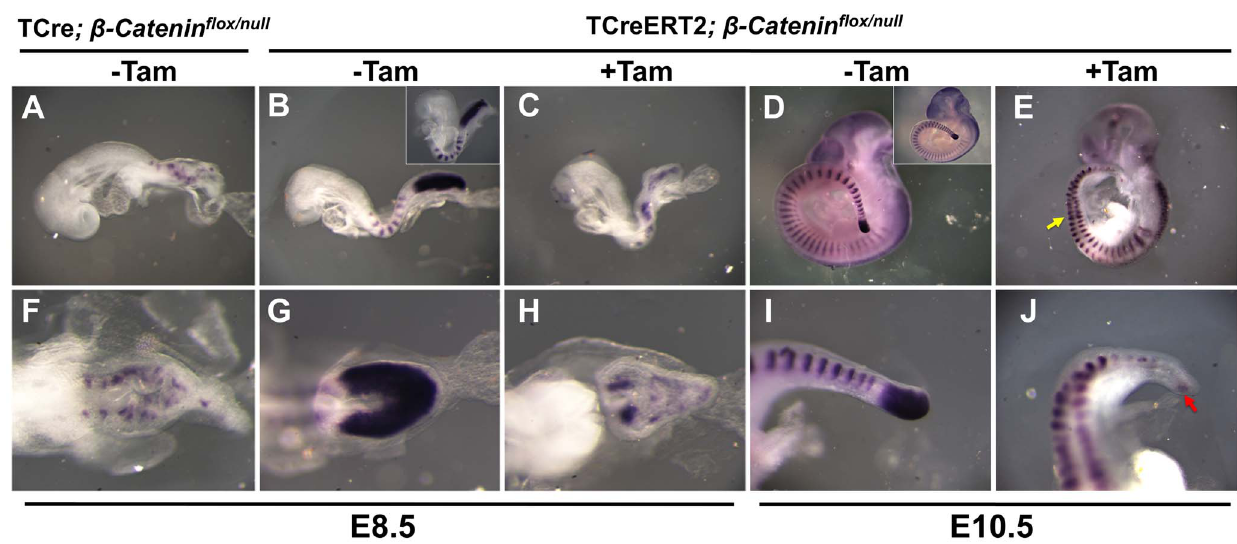
Figure 4. TCreERT2-mediated deletion of ß-catenin at different axial levels. All embryos shown, of the indicated genotype and stage, with or without a 48-hour Tam induction, were stained for expression of the markers Uncx4.1 and Msgn1 . Both markers were developed with the same color reaction, but they mark mutually exclusive domains: Uncx4.1 is expressed only in stripes in the somites and Msgn1 is expressed only in the PSM. A–E are lateral views and F–J are either dorsal views ( F–H ) or magnified views of the caudal end of the embryo immediately above ( I, J ). TCre- mediated deletion of ß-catenin causes caudal truncation and disorganized somites at E8.5 ( A, F ). These E8.5 defects are phenocopied in the Tam- induced TCreERT2; ß-catenin flox/null embryos ( C,H ) but not in the uninduced control ( B,G ), which is similar to a normal TCreERT2; ß-catenin flox/wt embryo (insert in B ). Tam induction can produce similar somitogenesis defects later in E10.5 TCreERT2; ß-catenin flox/null embryo ( E, J ). The yellow arrow in E indicates the axial level where caudal somite defects begin as indicated by Uncx4.1 staining. The red arrow in J points to residual Msgn1 expression. Uninduced E10.5 TCreERT2; ß-catenin flox/null control embryos ( D, I ) are similar to TCreERT2; ß-catenin flox/wt embryos (insert in D ).